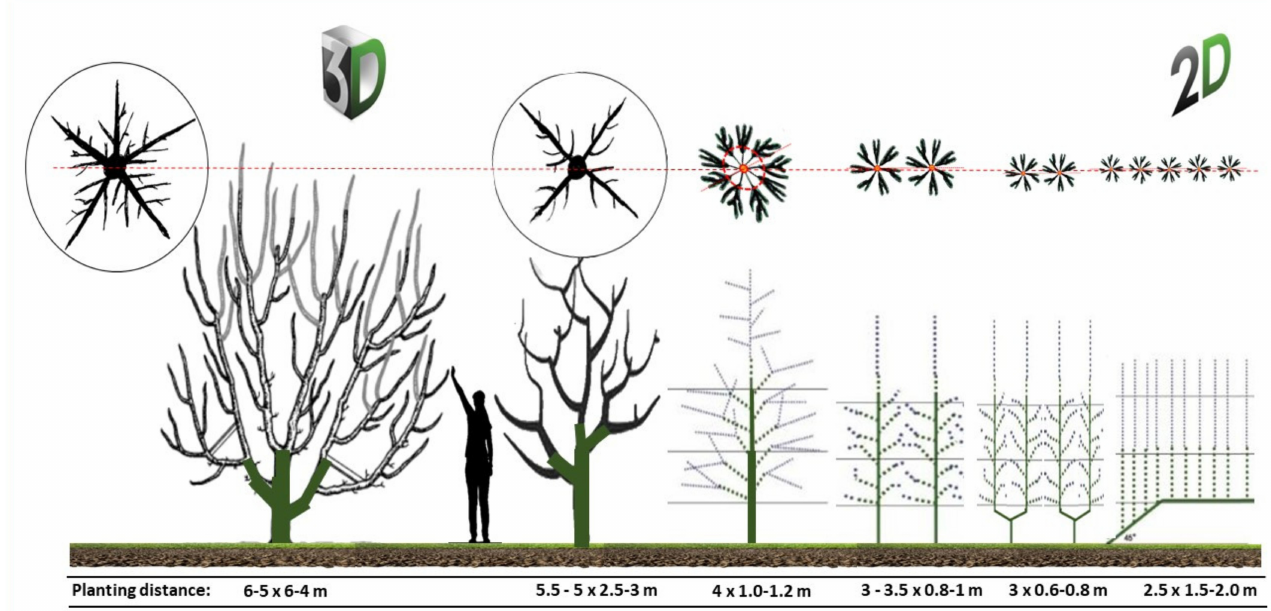
Figure 3. Evolution of training systems used or currently in use in pear over the last decades: from the traditional open vase through the modified central leader, axis, bi-axis, and multi-axis. The top part of the figure showcases the cross-section projection of the canopy [43].